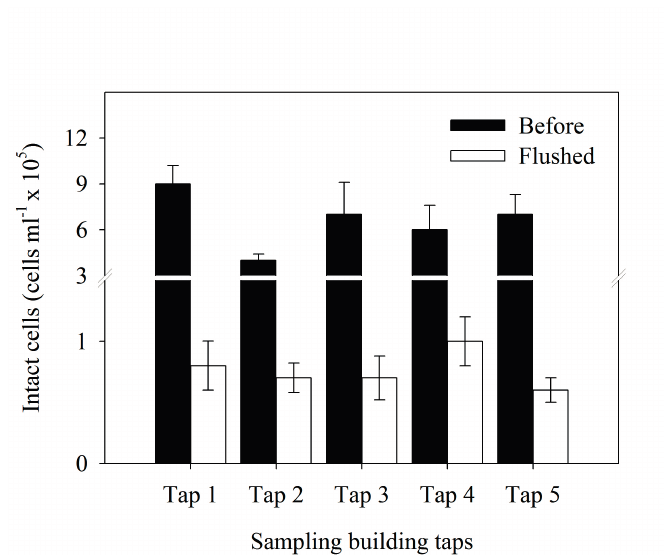
Figure 1. Intact bacterial cell numbers from the different sampling building tap waters before flushing (“before”) and after flushing for 10 min (“flushed”). The data is expressed by as the mean and standard errors ( n = 3). Table 3. Two-way ANOVA of the bacterial cell number and bacterial community functional metabolic profiles of the building tap water from before flushing (“before”) and flushed for 10 min (“flushed”) of Tap 1, Tap 2, Tap 3, Tap 4, and Tap 5. Bacterial Parameters Flushed ( F -Value) Tap ( F- Value) Interaction ( F -Value) Bacterial cell number 252.65 *** 12.56 ** 6.83 * AWCD 590nm 156.21 *** 16.92 ** 5.61 * Carbohydrates 58.61 ** 1.04NS 0.84NS Carboxylic acids 35.47 ** 6.32 * 5.04 * Amino acids 14.28 ** 4.59 * 1.09NS Polymers 1.53NS 0.96NS 0.08NS Phenolic compounds 19.21 ** 8.62 ** 1.68NS Amines 66.37 ** 0.43NS